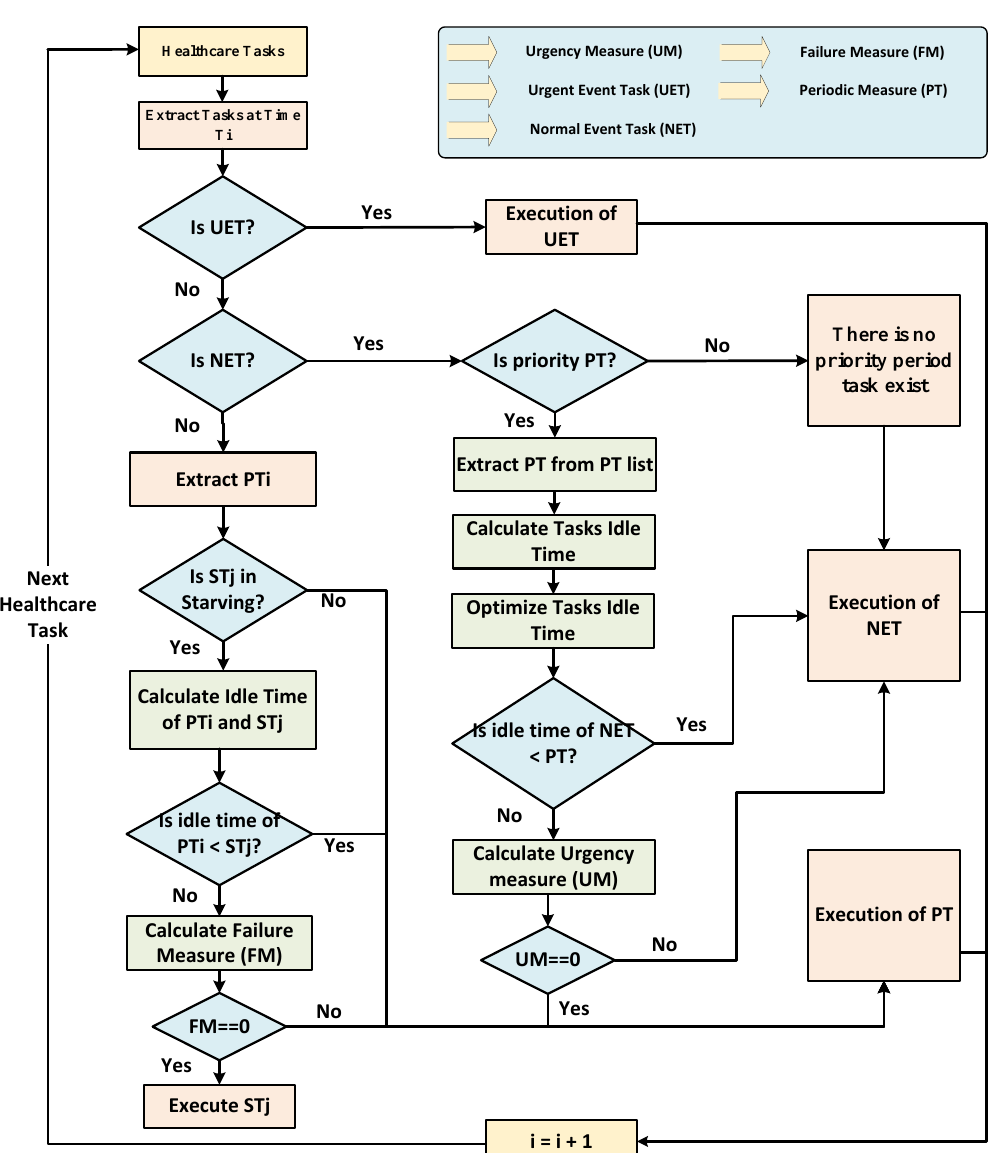
Figure 4. Flow of the proposed time-constraint aware scheduling